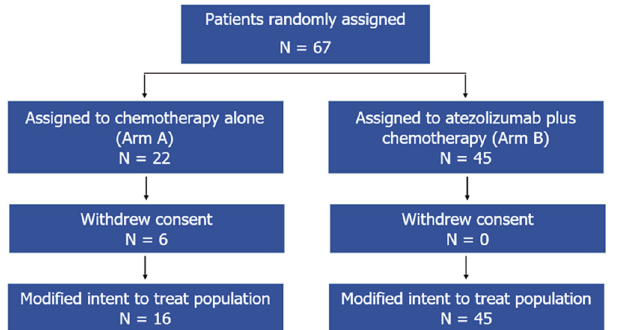
Fig. 1 CONSORT diagram. Flow of patients randomly assigned in NCI 10013.